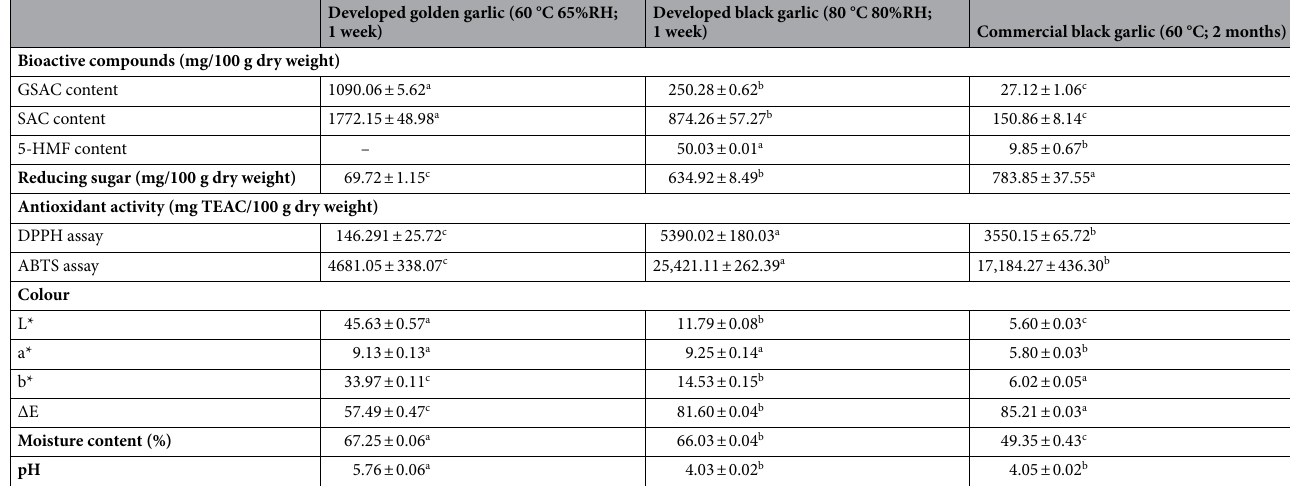
Table 3. Comparison of bioactive compounds and antioxidant activity of developed golden garlic, developed black and commercial black garlic. a– c Different superscripts within the same column indicate significant differences ( p ≤